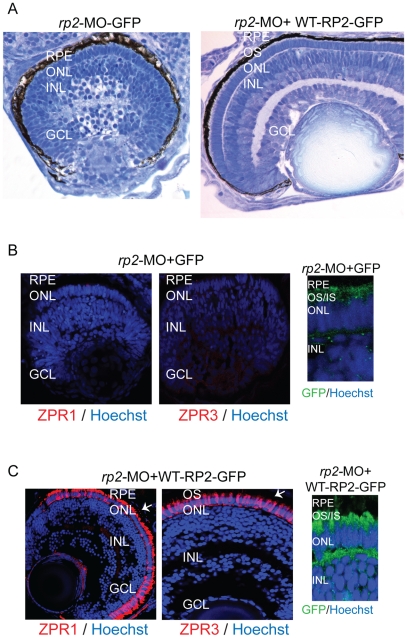
Human WT RP2 can rescue rp2-MO associated phenotype.
A. Histological analysis of retinas from embryos co-injected with rp2-MO and mRNA encoding GFP (left panel; rp2-MO + GFP) or wild type (WT) RP2-GFP fusion protein (right panel; rp2-MO + RP2-GFP). OS: outer segment; IS: inner segment; ONL: outer nuclear layer; OPL: outer plexiform layer. B and C. Immunofluorescence analysis of the indicated embryo retinas was performed using Zpr1 or Zpr3 antibodies (red; arrows) or anti-GFP antibodies (green). Hoechst was used to stain nuclei (blue). OS: outer segment; IS: inner segment; ONL: outer nuclear layer; INL: inner nuclear layer; GCL: ganglion cell layer.